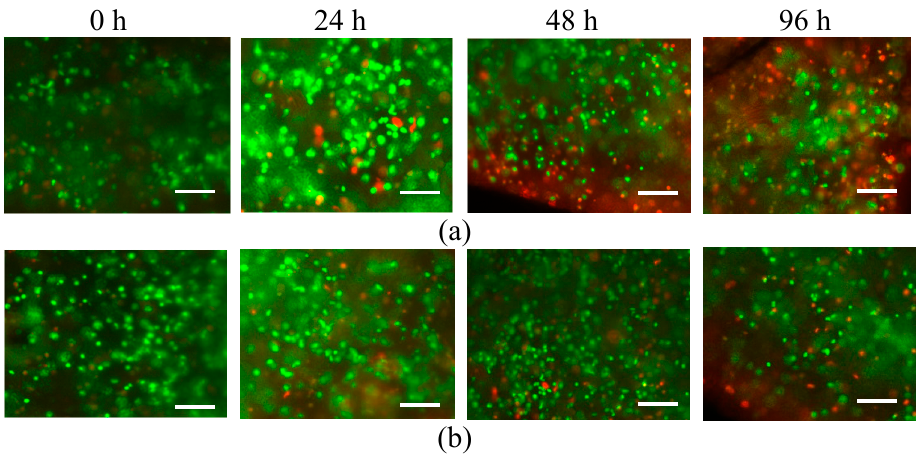
Figure 9. SEM images showing pore sizes after different hours of incubation for ( a ) 10% GelMA with no encapsulated cells and ( b ) 10% GelMA with a cell density of 5 × 10 6 cells/mL (scale bar represents 300 µm).